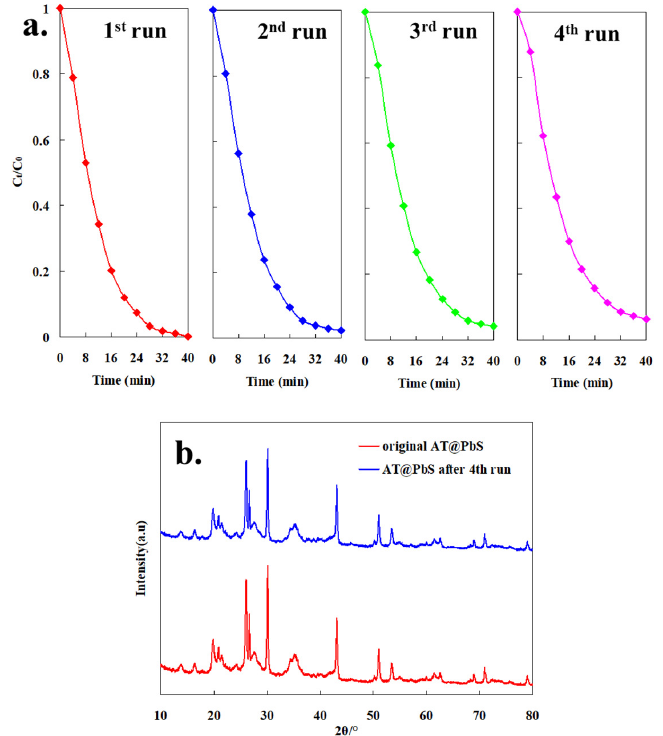
Figure 9. ( a ) The degradation curve of AT@PbS (attapulgite/lead sulphide composite) catalyst reused under visible light, ( b ) the XRD (X-ray diffraction) patterns of AT@PbS (attapulgite/lead sulphide composite) before and after 4th photocatalysis experiment.